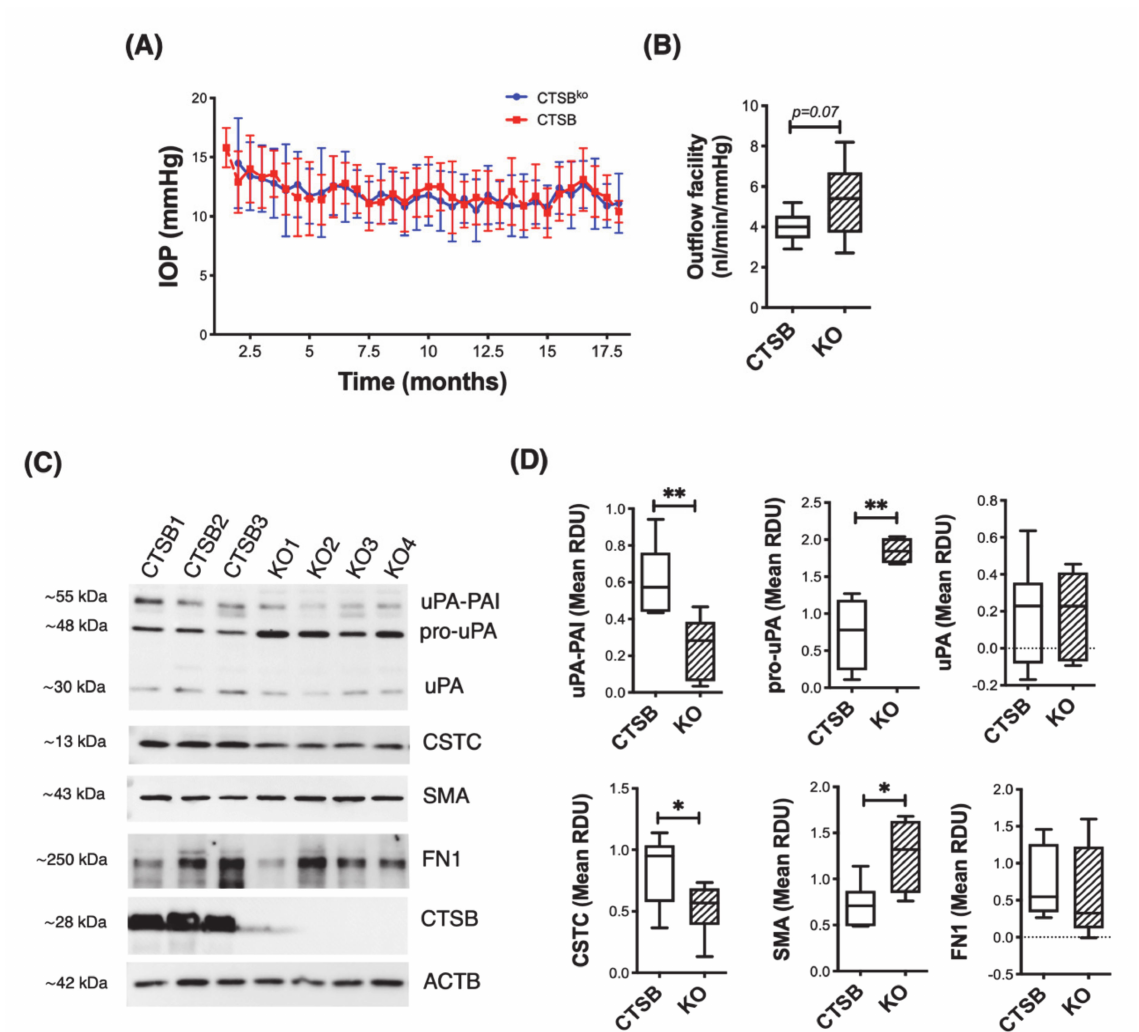
Figure 6. Effect of CTSB deficiency in outflow pathway physiology and morphology. ( A ) Mean IOP (mm Hg) over time in CTSB ko and CTSB mice. Data are shown as the mean ± S.D., n = 20. ( B ) Mean outflow facility in CTSB ko and CTSB mice (4 m.o.) evaluated ex-vivo with the iPerfusion system. Data are shown as the mean ± S.D., n CTSB = 10, n CTSBko = 11. ( C ) Protein levels of uPA (uPA/PAI, pro-uPA, uPA), CTSC, SMA, FN1, and CSTB evaluated by WB in whole cell lysates (5 µ g) from primary hTM cells. Relative protein levels were calculated from densitometric analysis of the bands and represented in ( D ). Data are shown as the mean ± S.D. * p < 0.05, ** p < 0.01; t -test, n =